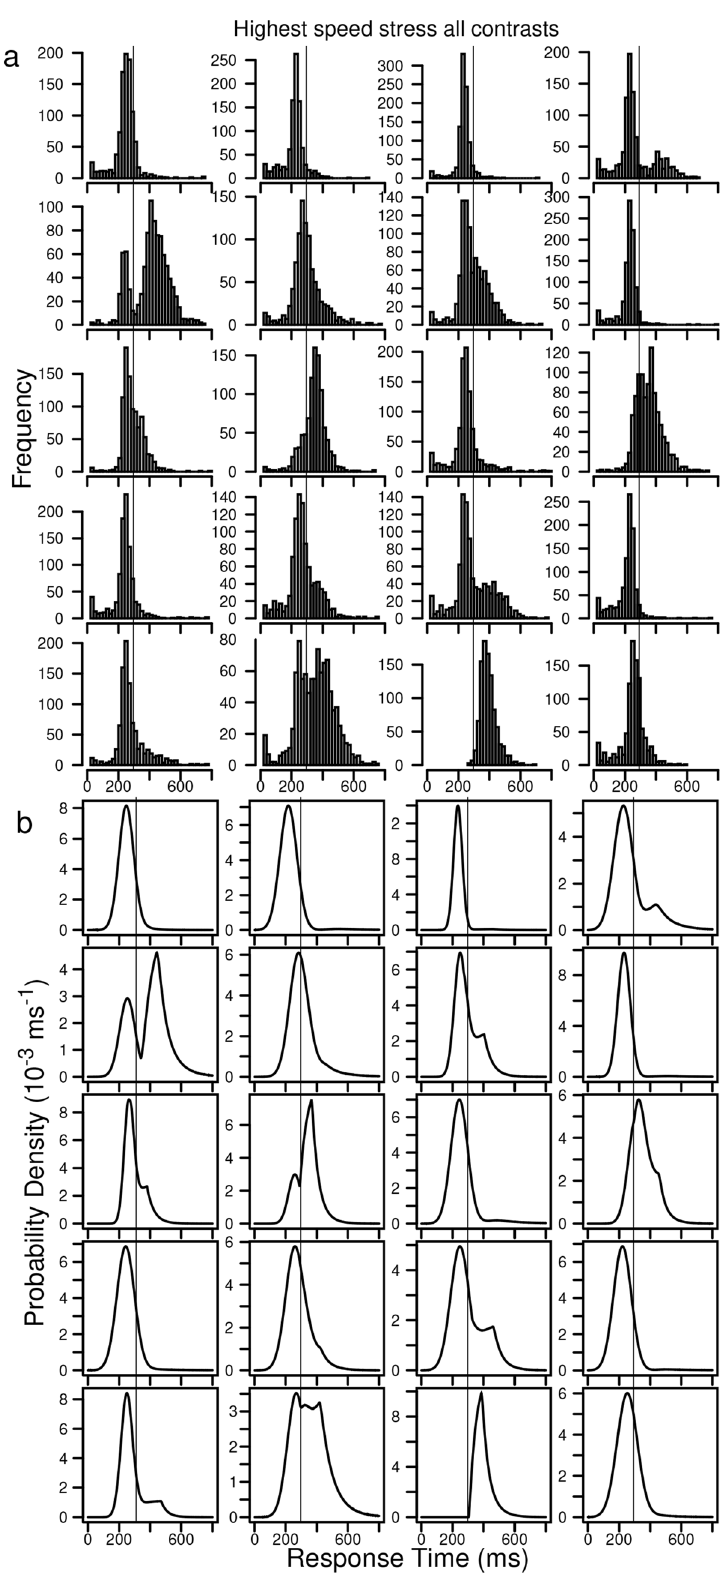
Figure 3. ( a ) Empirical correct RT distributions for the highest speed-stress conditions (collapsed over the levels of stimulus contrast) for each of the 20 individual subjects. ( b ) The same plots for predictions generated from fits of the mixture model to the data. The thin vertical lines at 300 ms provide an approximate way of separating fast guesses (those below 300 ms) from stimulus-based